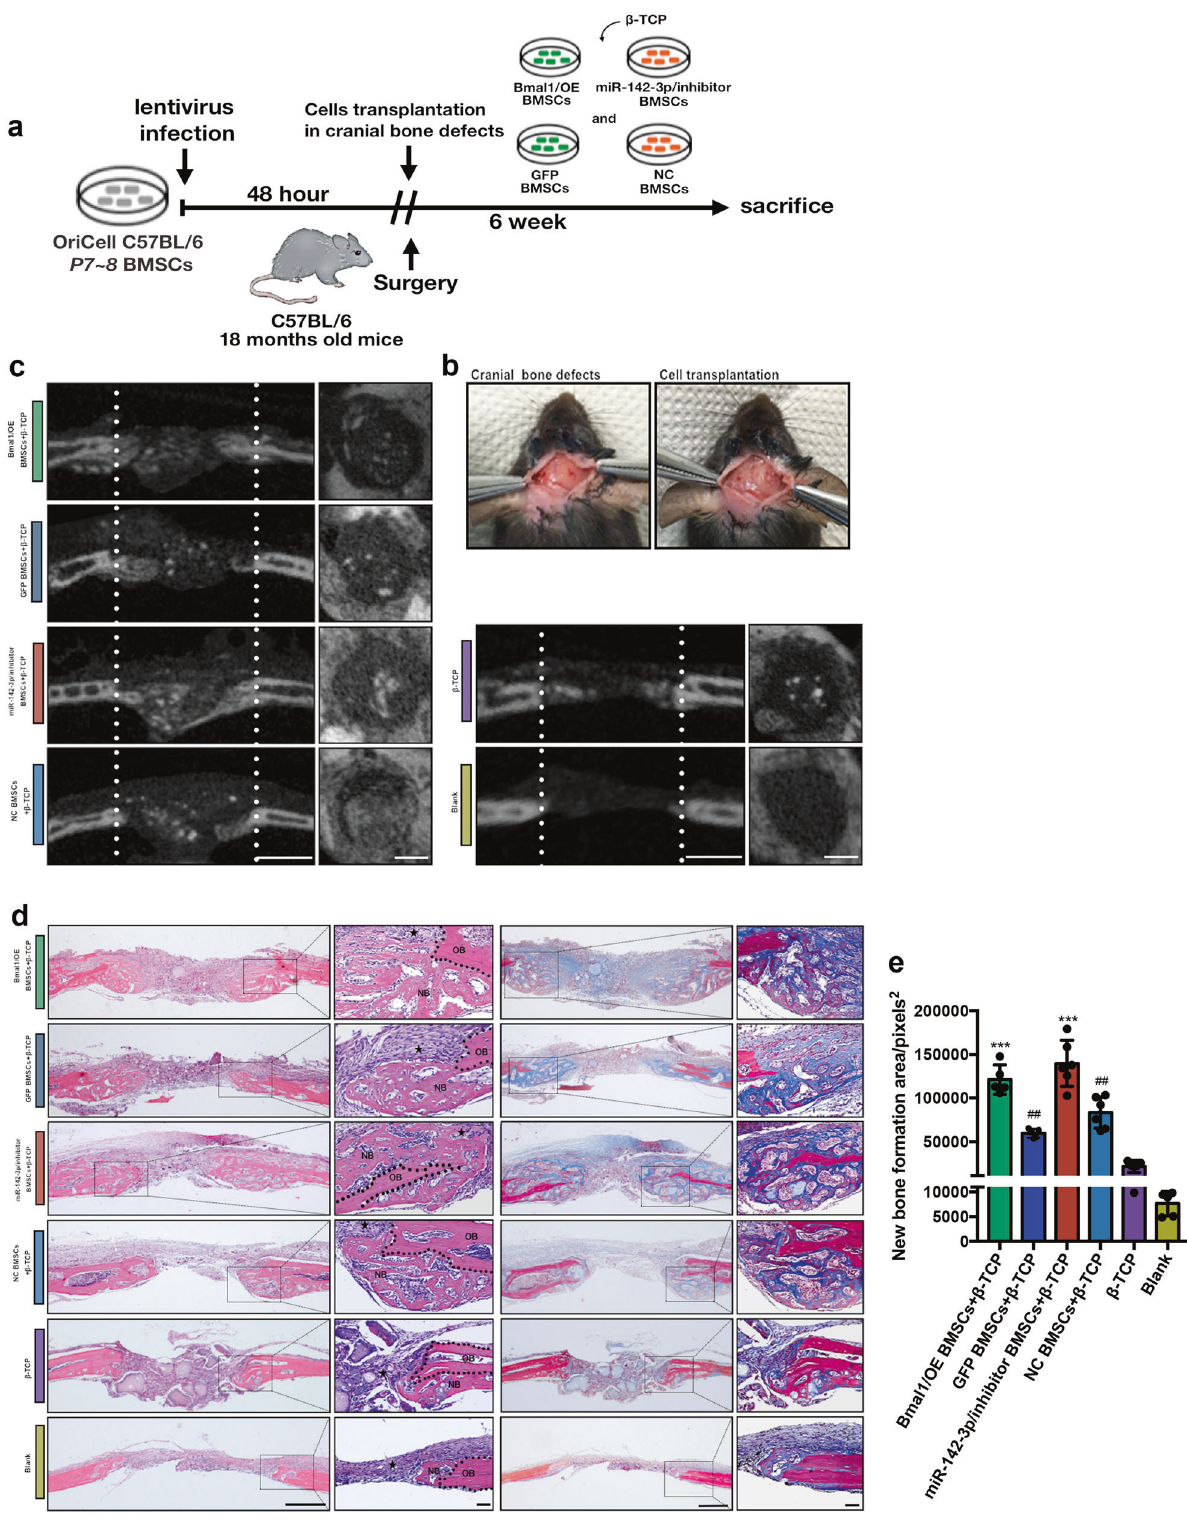
Fig. 5 Bmal1/OE and miR-142-3p/inhibitor BMSCs promotes bone formation in cranial defects of aged mice. a Flow chart diagram of the cell transplantation process. b Photograph of animal surgery and cell transplantation procedure in mice. c micro-CT images of the cells transplanted defect sites. Scale bar: 500 μ m. d H&E staining (H&E) and Masson trichrome staining (Masson) of cells transplanted defect sites. NB represents new bone, OB represents old bone, and represents connective tissue. Scale bar: 100 μ m for 4x images, 50 μ m for 10x